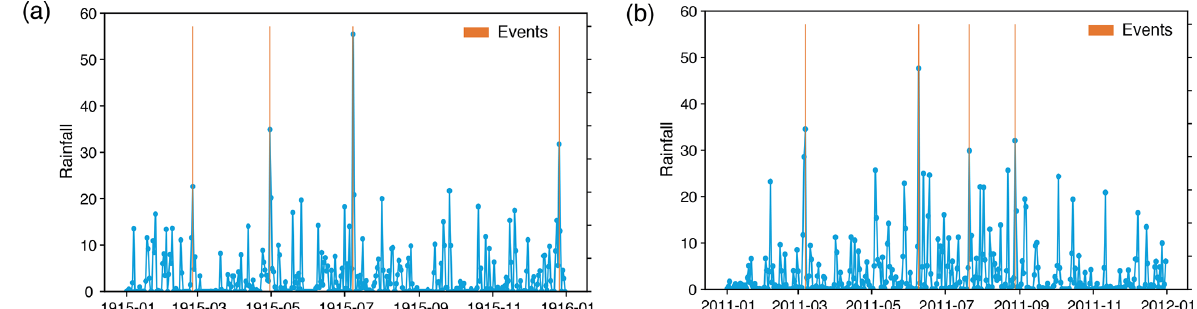
Figure 4. Daily precipitation time series of the Aroostook River catchment near Masardis, Maine, in the United States for the years (a) 1915 and (b) 2011; red bars indicate extreme rainfall events (four events per year), usually occurring in spring and summer, whereas in fall extreme rainfall events usually do not occur.